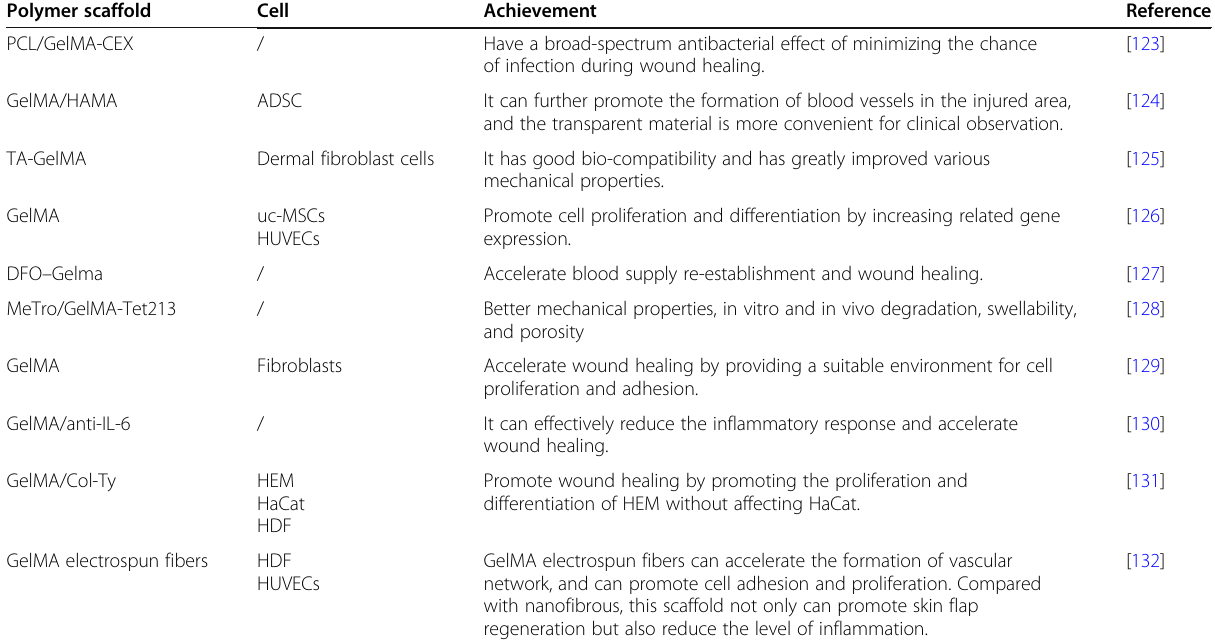
Table 7 The recent application of GelMA in skin tissue engineering Polymer